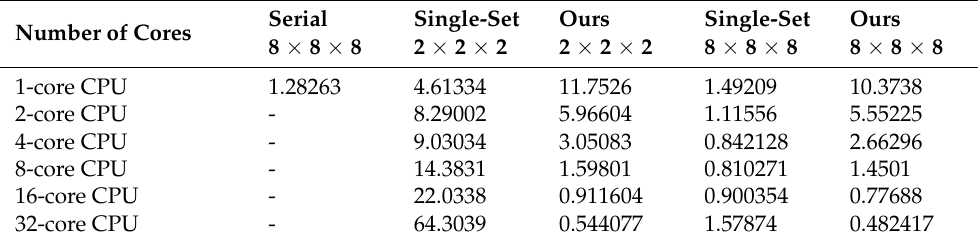
Table 3. The computation time of our proposed parallel multi-set histogram algorithm and the parallel single-set histogram modeling algorithm. The computation time is in seconds. Number of Cores